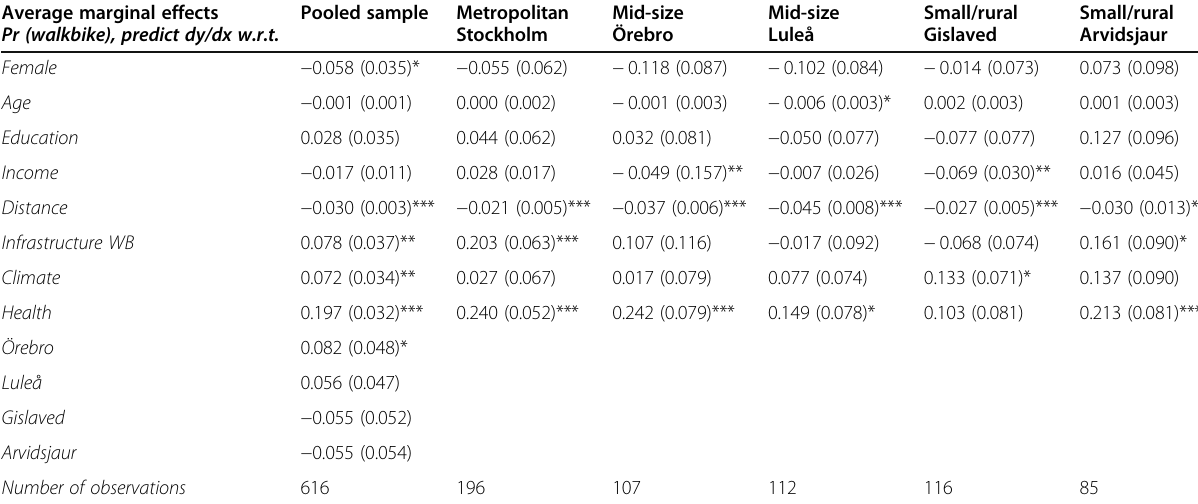
Table 6 Estimated marginal effects (standard errors in